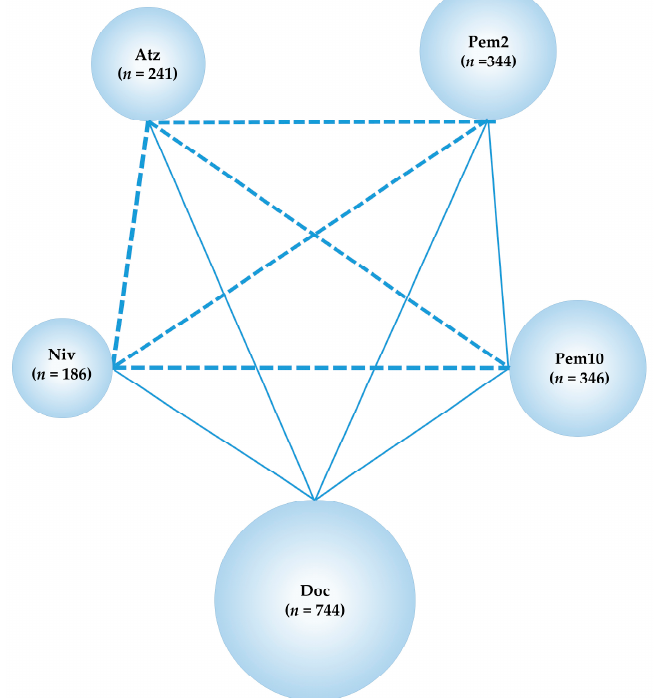
Figure 10. Network map of subgroup analysis for refractory or relapse PD-L1-positive ( ≥ 1%) advanced NSCLC. Solid lines represent randomized controlled trials (RCTs), and relative thickness represents the number of included studies. The dashed line reveals the absence of RCTs, suggesting that an indirect treatment comparison could be attempted. Circle size reflects the proportion of patients included in each treatment group. Ram+Doc, ramucirumab plus docetaxel; Niv, nivolumab; Atz, atezolizumab; Pem2, pembrolizumab 2 mg/kg; Pem10, pembrolizumab 10 mg/kg; n, number of patients.